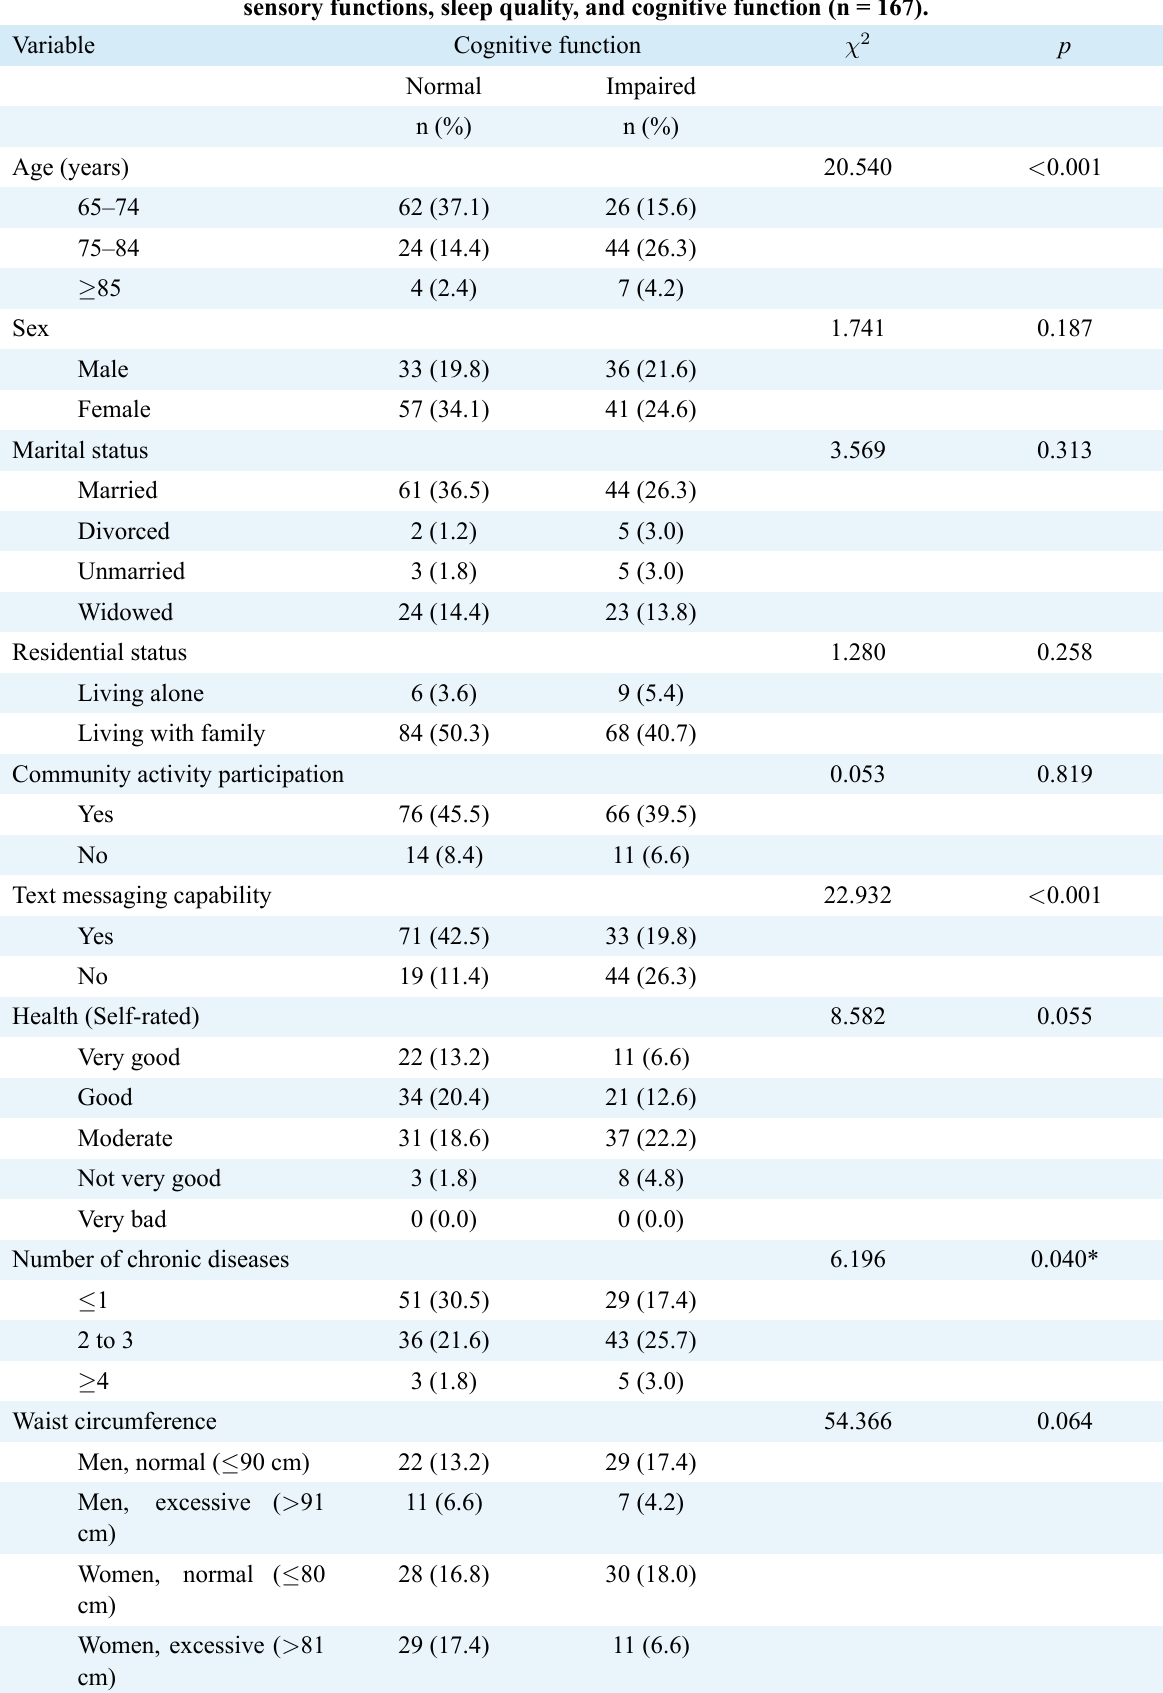
TABLE 2. Participant differences in demographic characteristics, physiological indexes, psychological resilience, sensory functions, sleep quality, and cognitive function (n =